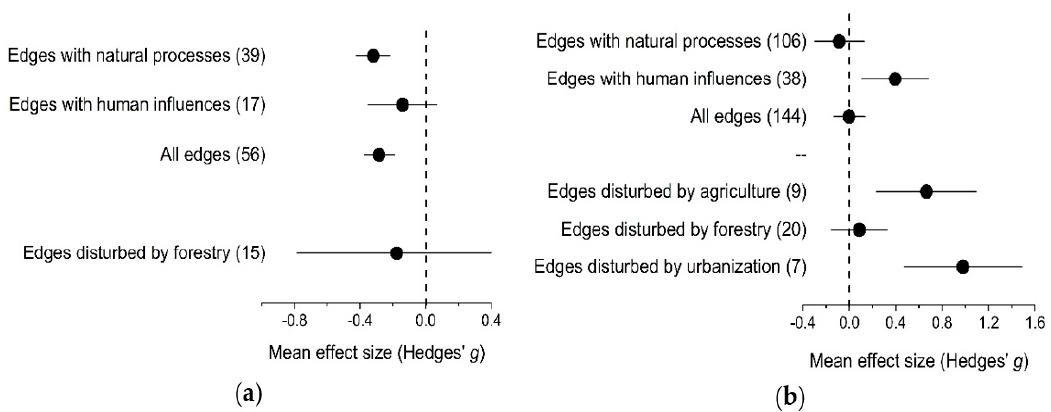
Figure 1. Mean e ff ect sizes of random-e ff ect models ( ± 95% confidence interval) for the abundance of flying grasslander (good disperser open-habitat) ( a ), and walking specialist (poor disperser forest specialist) ground beetle species ( b ). Values in brackets show the number of abundance values for which the mean e ff ect size was calculated. Mean e ff ect size was only calculated for edge-to-interior comparisons of abundance data with ≥ 5 cases. A negative g value indicates higher abundance in forest edges than interiors. Mean e ff ect size is statistically significant when the confidence interval did not include zero.